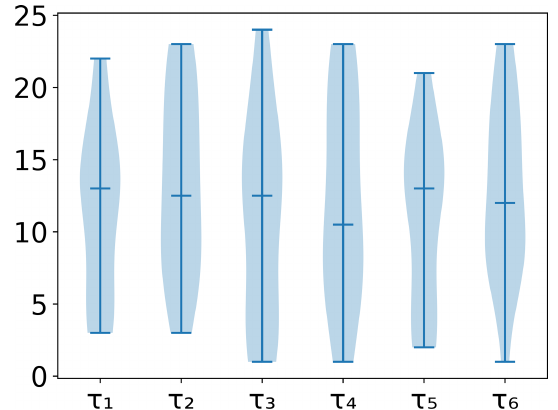
Figure A4. Distribution of time lags obtained after fitting the test model to the Fluxnet sites. Shown here are the distributions used for generation of homoscedastic time